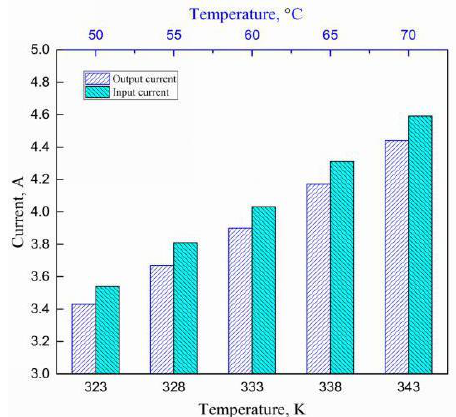
Figure 10. Relationship between current and temperature in physical simulation.